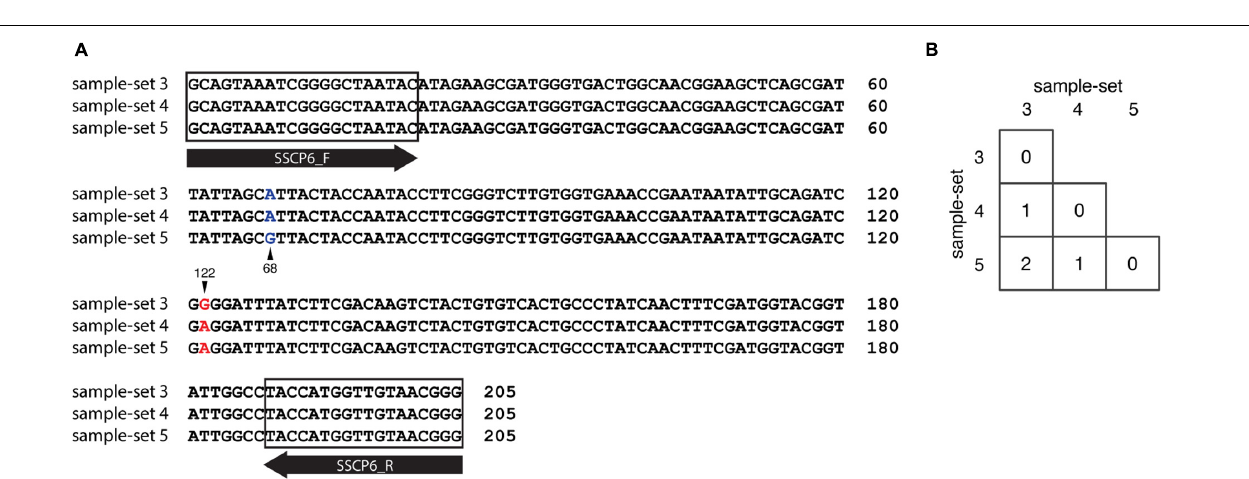
FIGURE 7 | Nucleotide substitution variations among the single-strand conformation polymorphism (SSCP) regions of sample-sets 3–5. Multiple sequence alignment of 205 nucleotides of SSCP sequences of sample-sets 3–5 was generated. (A) Nucleotide substitutions at positions 68 (column with blue text) and 122 (column with red text). The sample-set is presented on the left-hand side of the alignment, whereas the nucleotide position is shown on the right. Primer binding regions and direction are shown in the gray boxes and open arrows, respectively. The number of nucleotide substitutions between each nucleotide sequence pair is shown in the matrix (B)